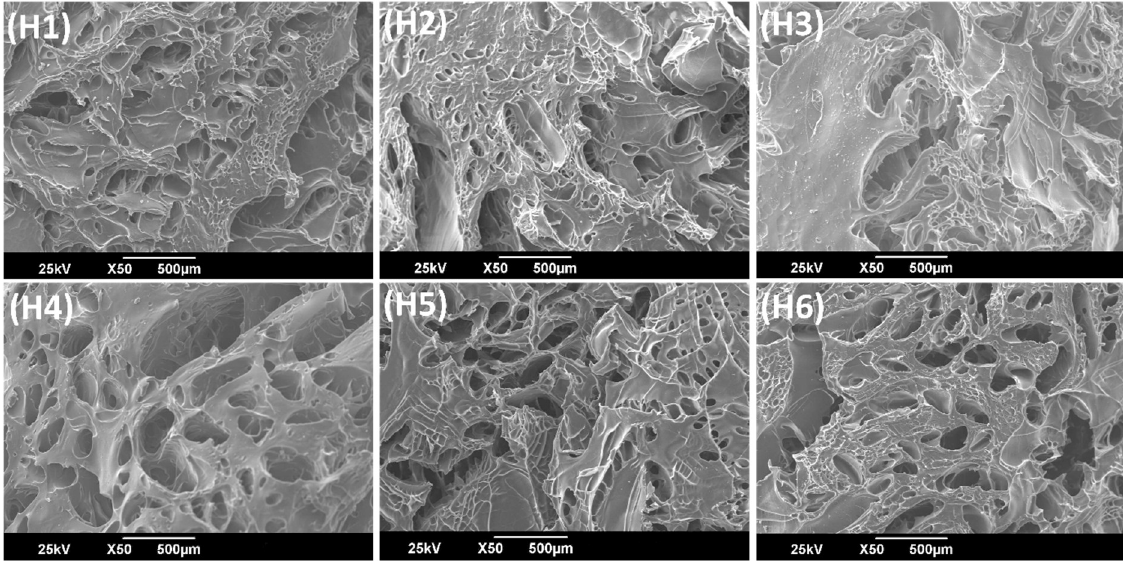
Figure 3. Scanning electron microscopy images of AlgNa-g-poly(QCL-co-HEMA) hydrogels.